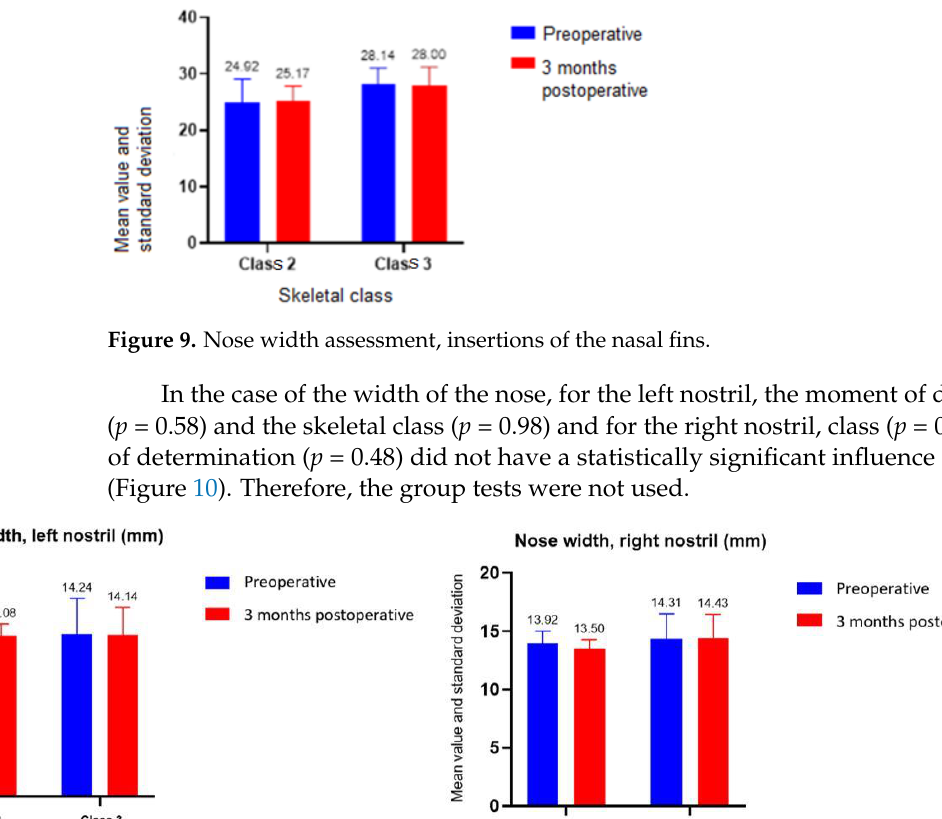
Figure 10. Nose width assessment, right and left nostrils.